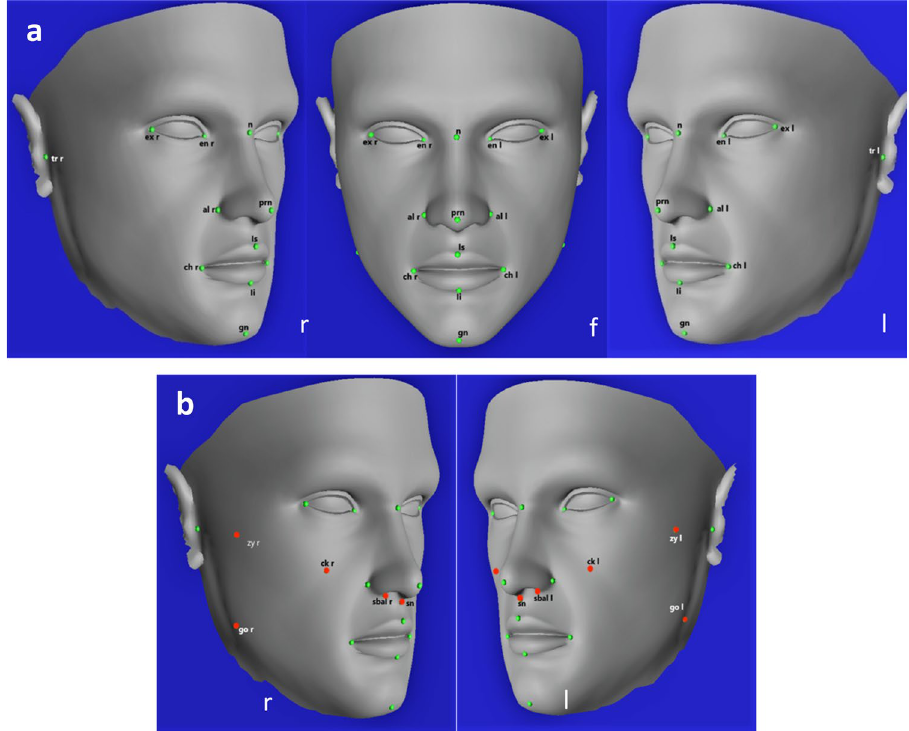
Figure 1. Generic mesh in Di3DViewViewer with registration landmarks ( a) 15 landmarks for conformation in Di3DView and MorphAnalyser; ( b) extra 9 landmarks for conformation in